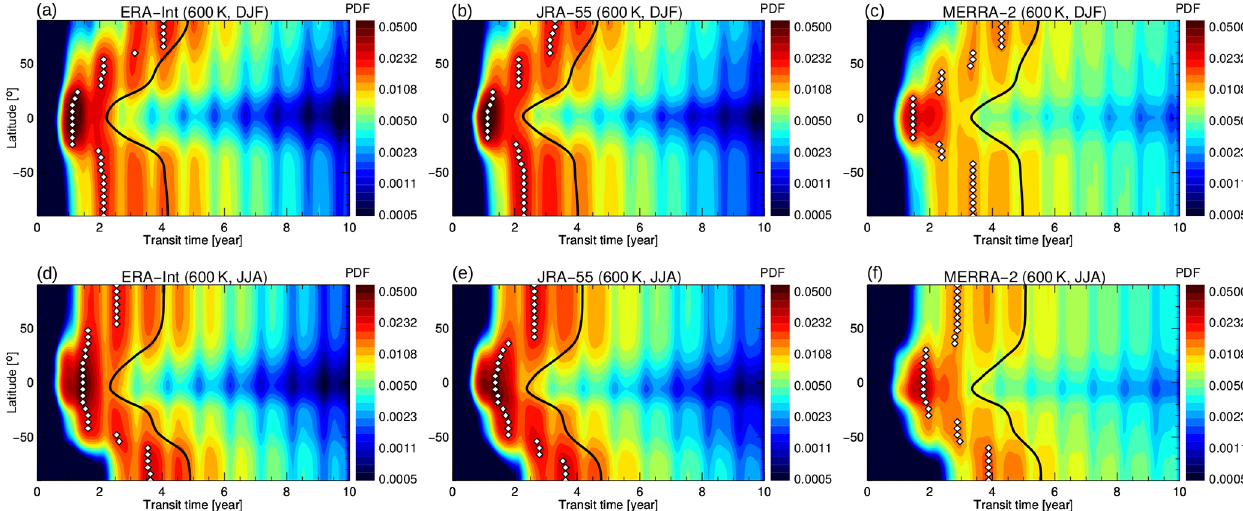
Figure 4. Same as Fig. 3, but at the 600K potential temperature